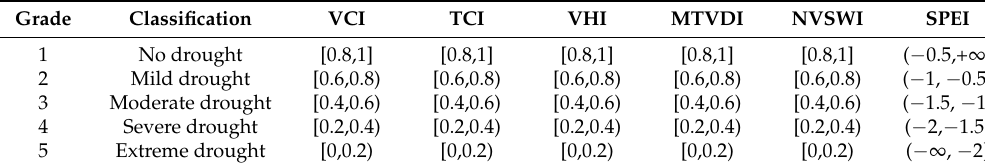
Table 2. Classification of drought indices used in this